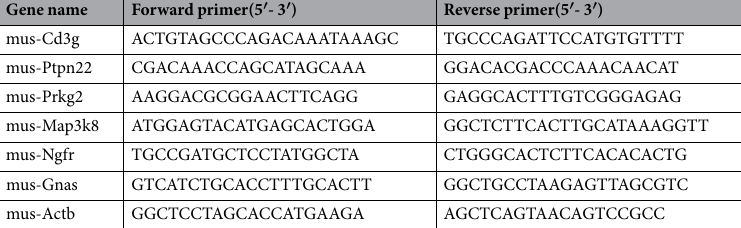
Table 5. Target- mRNA sequences obtained from the NCBI